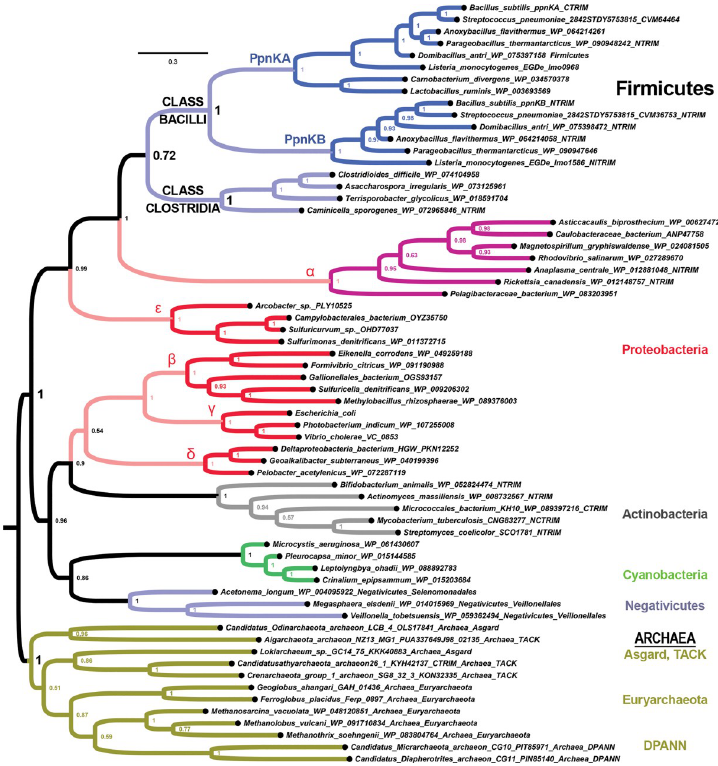
Fig 7. A bacterial duplication of nadK in the Firmicutes class of Bacilli. Identification of a duplication of nadK into ppnKA and ppnKB in the occurred after the Bacilli class split with its sister class of Clostridia. The Bacilli class of Firmicutes corresponds to aerobic endospore formers while the Clostridia class corresponds to anaerobic endospore formers. See S1 Fig for a more complete tree that includes the independent duplications in Actinobacteria and Eukaryotes.